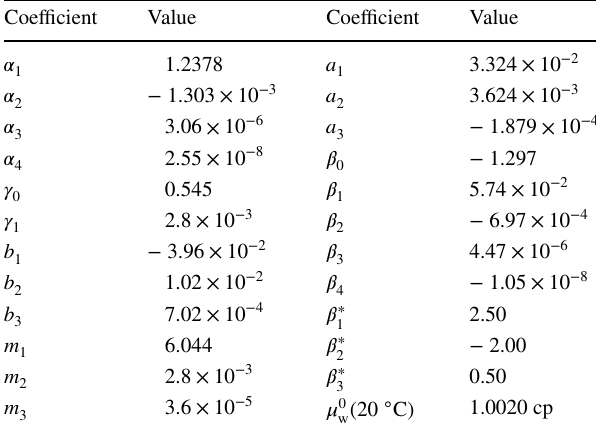
Table 8 Values of constant coefficients in brine viscosity